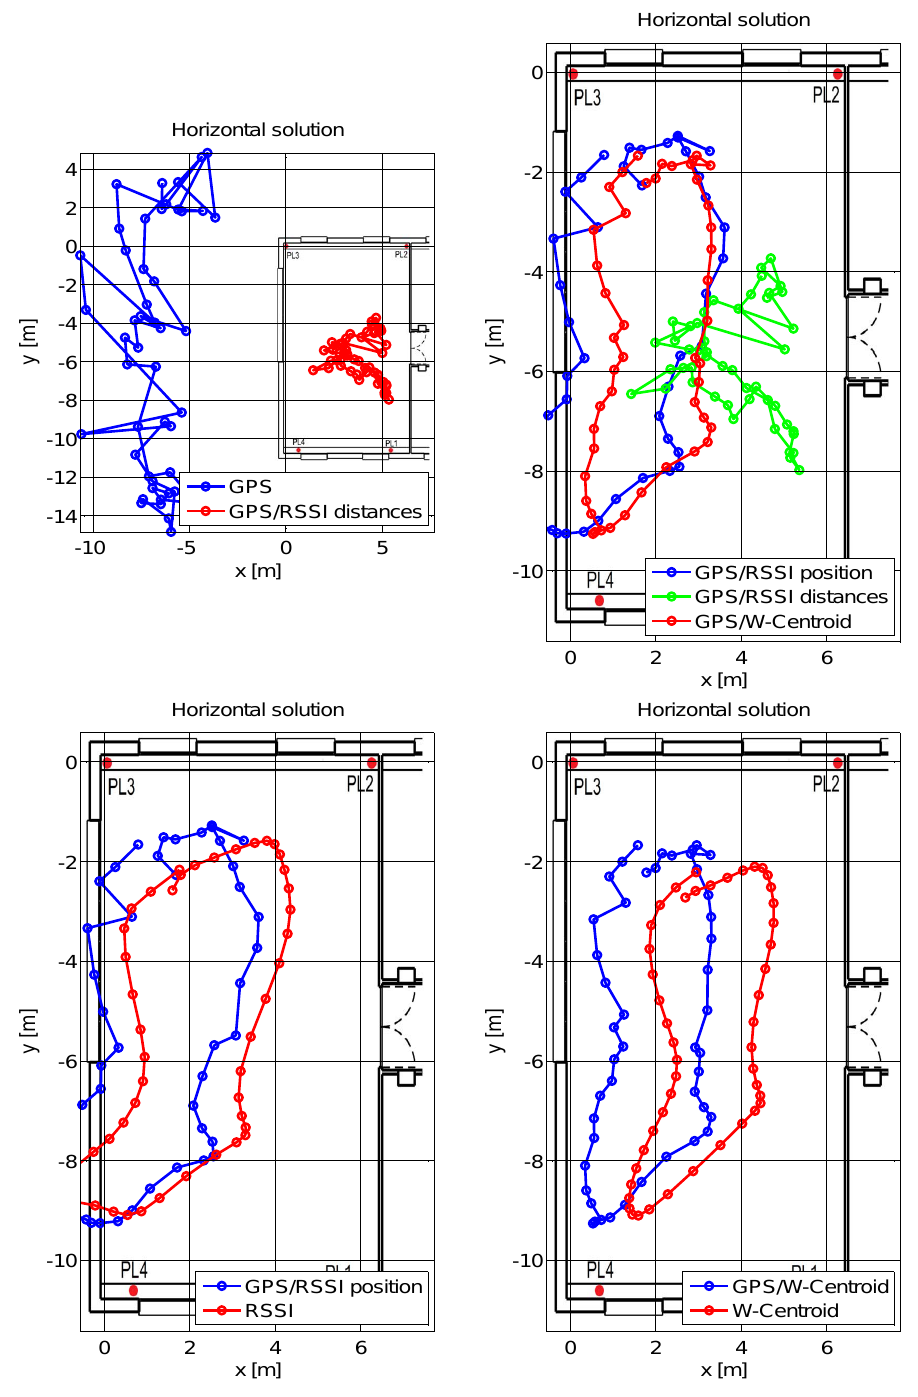
Figure 12. Horizontal solution estimated for the repeatability test performed in a large meeting room. A single lap is provided for improving the clarity of the